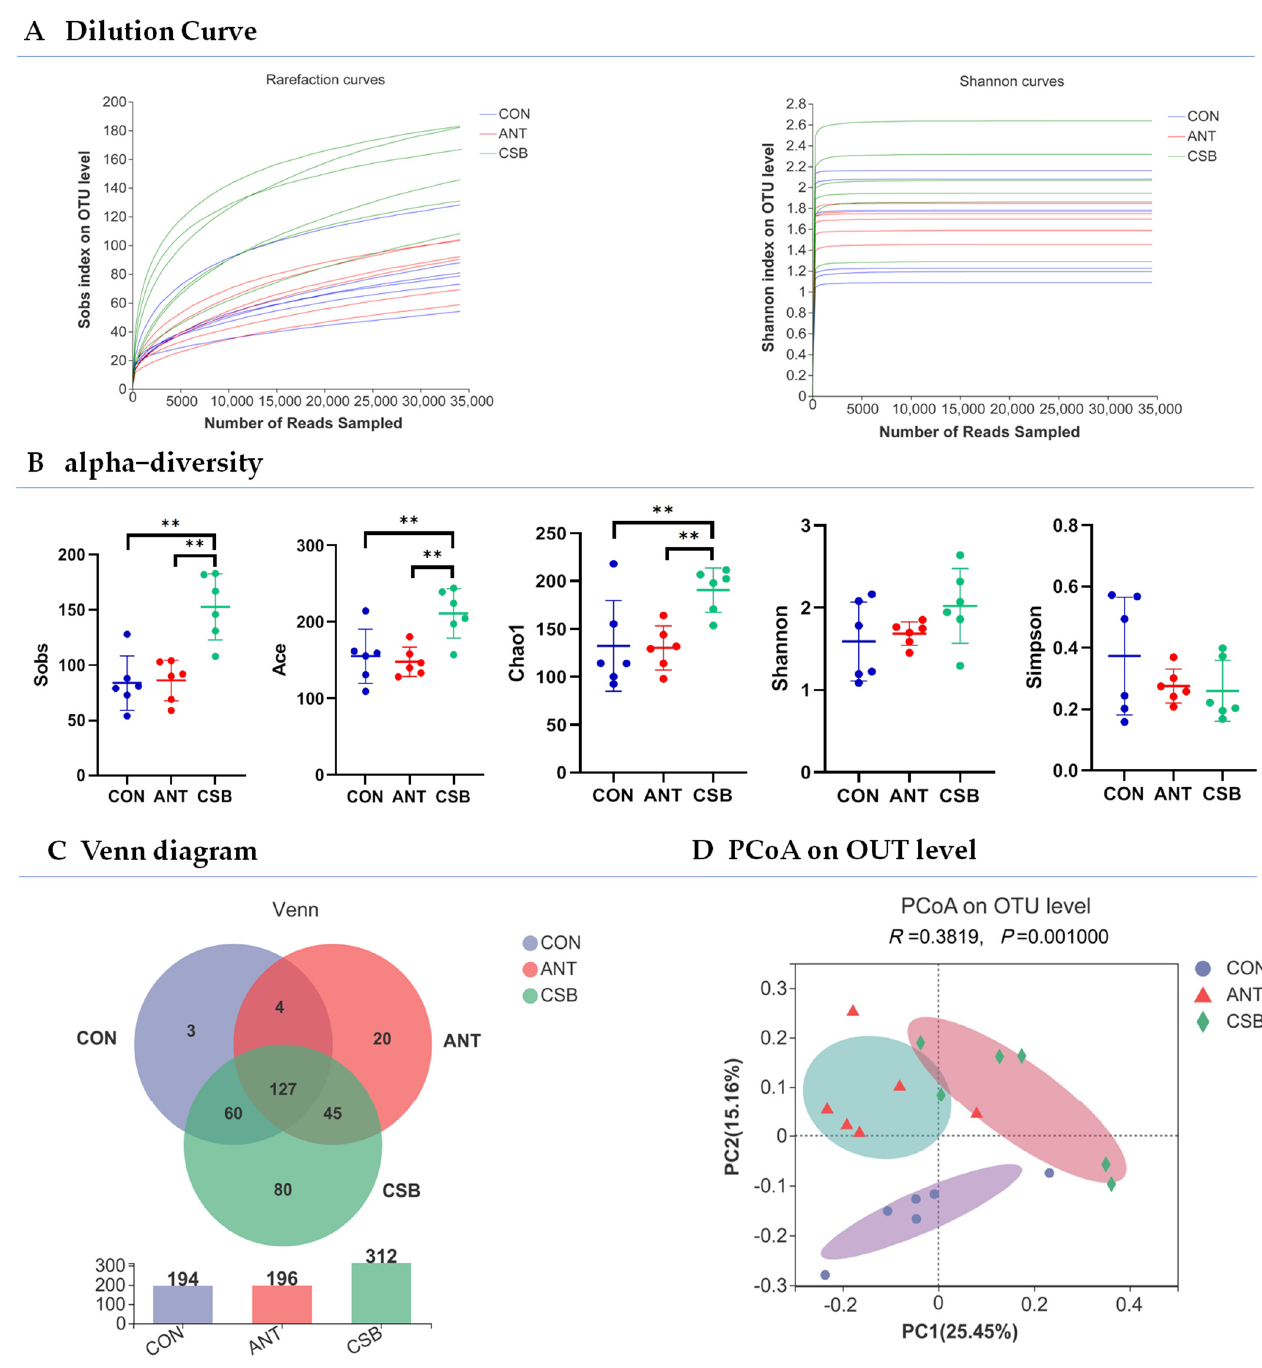
Figure 5. Effects of CSB addition on the microbial diversity of ileum in broilers at 21 d of age ( n = 6). ** 0.001 < p ≤ 0.01.